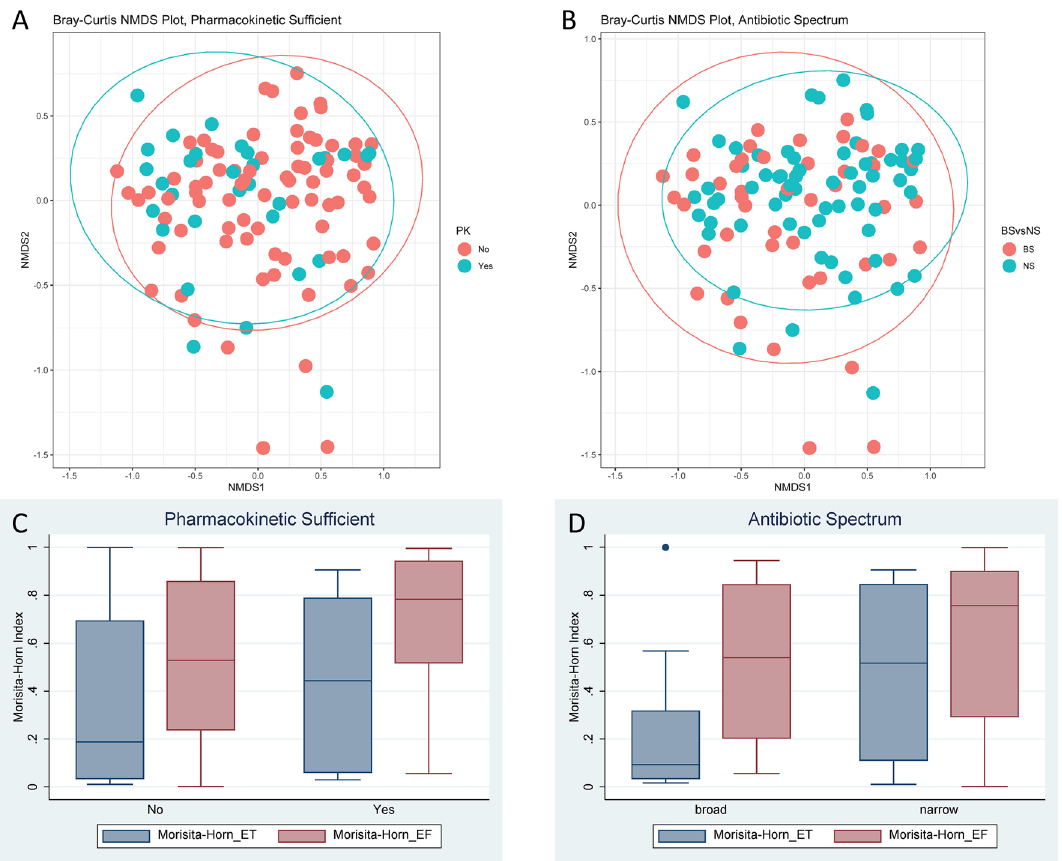
Figure 3. Changes in beta diversity. Panel ( A ) Bray–Curtis Non-metric multidimensional scaling (NMDS) Plot, Pharmacokinetic Sufficient. Panel ( B ) Bray–Curtis NMDS Plot, Antibiotic Spectrum. Panel ( C ) Morisita–Horn Index, Pharmacokinetic Sufficient. Panel ( D ) Morisita–Horn Index, Antibiotic Spectrum. NMDS, non-metric multidimensional scaling; PK, pharmacokinetic; E, pulmonary exacerbation; T, end of treatment; F, follow up; ET, change between pulmonary exacerbation and end of treatment; EF, change between pulmonary exacerbation and follow-up. On the NMDS plots, the ellipses represent the t distribution. The permutational multivariate analysis of variance (PERMANOVA) result for beta-lactam PK was p = 0.120 and for antibiotic spectrum was p = 0.133. On the box and whiskers plots, the center horizontal line corresponds to the median and the colored boxes represent the interquartile ranges. Small circles represent individual values that were